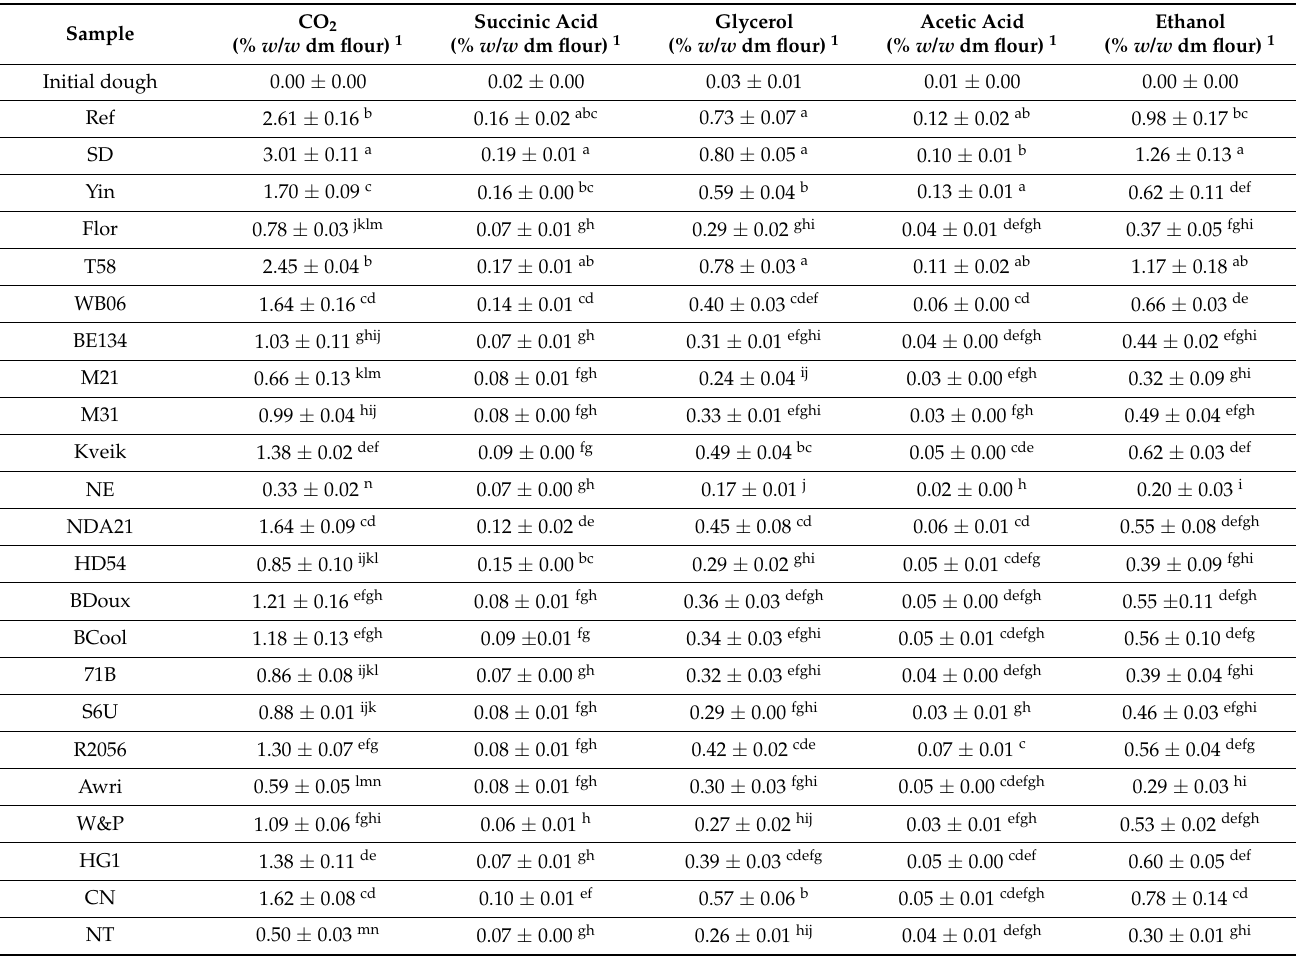
Table 2. CO 2 production and ethanol, glycerol, succinic acid, and acetic acid concentrations in doughs with 23 different yeast strains after a fermentation step of 120 min at 30 ◦ C. Concentrations are expressed on flour dry matter base (% w / w dm flour). Standard deviations of triplicate measurements are presented for each